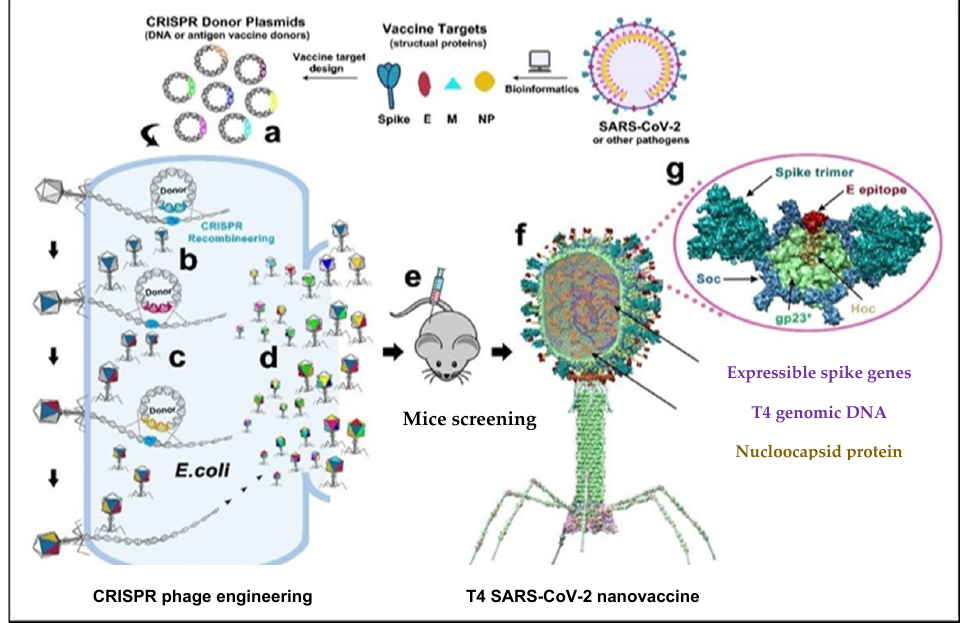
Figure 4. The genome of T4 phage was packed with engineered DNAs analogous to various components of SARS-CoV-2 virion. E. coli was grown and DNAs were inserted into it as a donor plasmid (a) CRISPR-targeted genome editing used for recpmbination into injected phage genome (b). Phage infections generated the several combinations of CoV-2 inserts and identified the recombinant phages in the progeny (c). For example, recombinant phage containing CoV-2 insert #1 (dark blue) can be used to infect CRISPR E. coli containing Co-V2 insert containing donor plasmid #2 (dark red). The progeny plaques obtained will contain recombinant phage #3 with both inserts #1 and #2 (dark blue plus dark red) in the same genome. This process was repeated to rapidly construct a pipeline of multiplex T4-SARS-CoV-2 vaccine phages (d). Selected vaccine candidates were then screened in a mouse model (e) to identify the most potent vaccine (f). Structural model of T4-SARS-CoV-2 Nanovaccine showing an enlarged view of a single 118 hexameric capsomer (g). The capsomer shows six subunits of major capsid protein gp23* (green), 119 trimers of Soc (blue), and a Hoc fiber (yellow) at the center of capsomer. The expressible spike genes are inserted into phage genome, the 12 aa E external peptide (red) is displayed at the tip of Hoc fiber, S-trimers (cyan) are attached to Soc subunits, and nucleocapsid proteins (yellow) are packaged in genome core. See Results and Materials and Methods for additional details. [28]. Reproduced with permission from [Venigalla B. Rao], [Science Advances]; published by [AAAS],